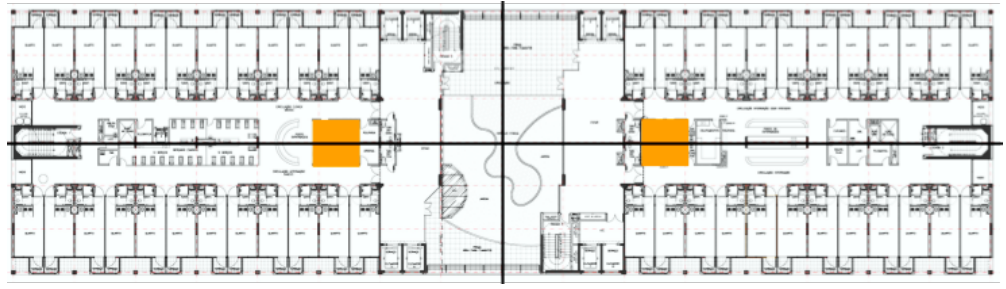
Figure 10. Hospital map.